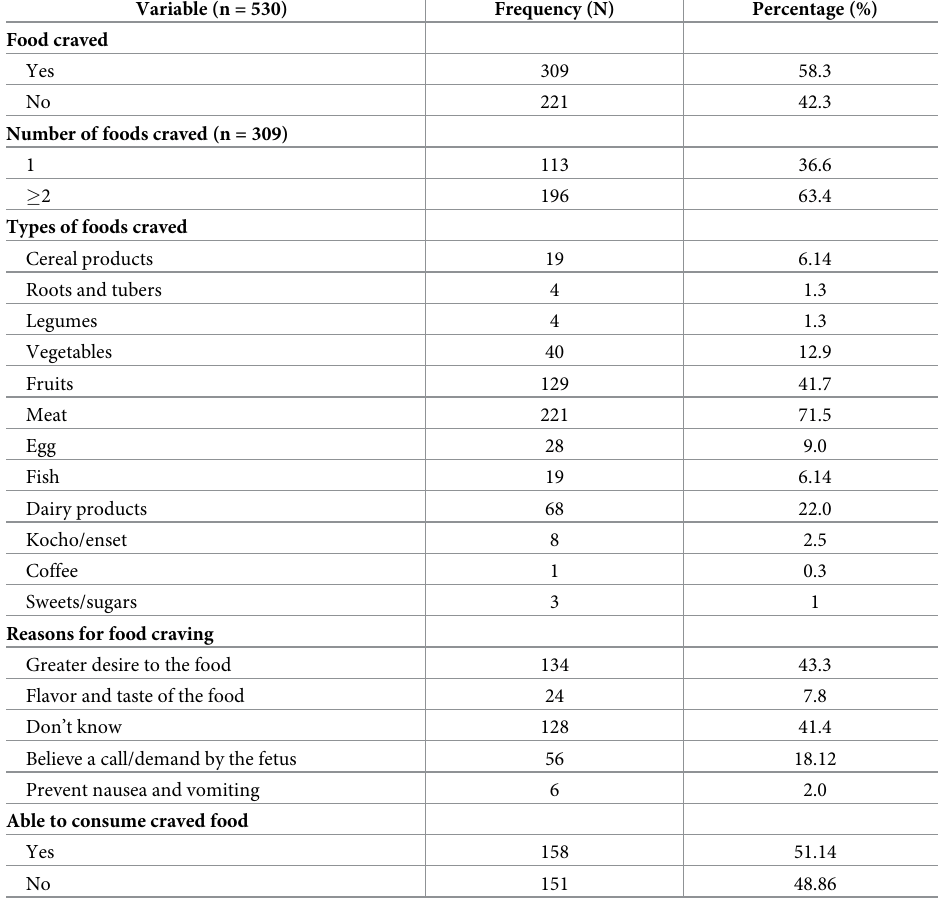
Table 3. Magnitude and types of food craving among pregnant women in Sidama Regional State, Southern Ethio- pia, 2021. Variable (n = 530) Frequency